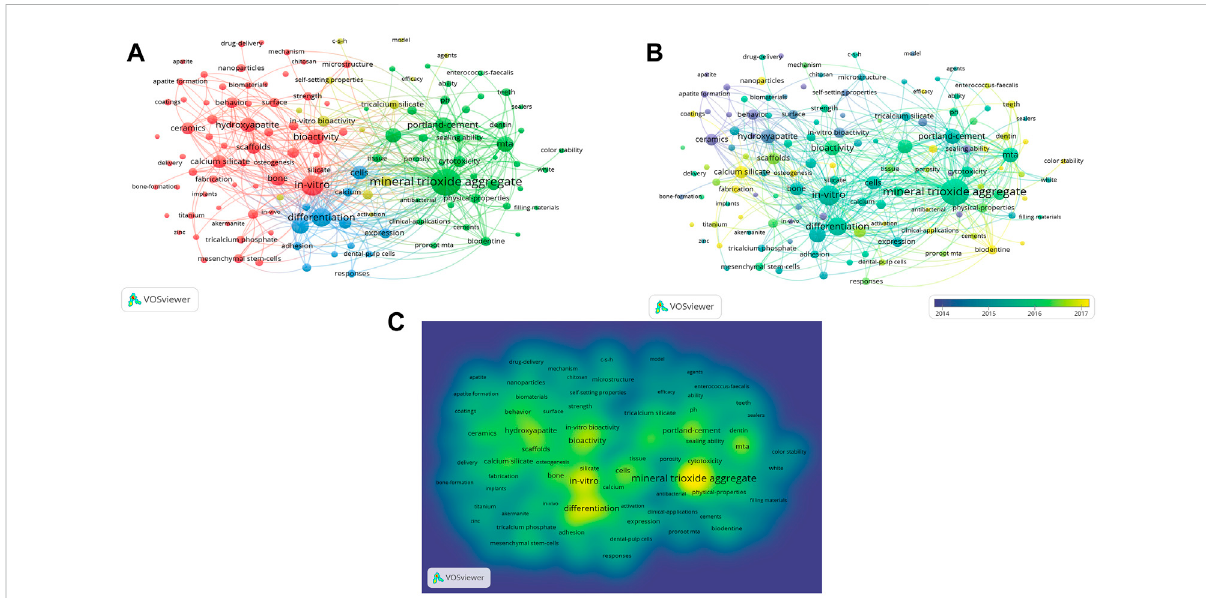
FIGURE 7 Bibliometric analysis of keywords. (A) Map of Clusters based on keywords analysis (B) Distribution of keywords plus according to average publication year.The occurrencesofthemetermswereindicated bythesize ofthecircles. Thedistancebetween